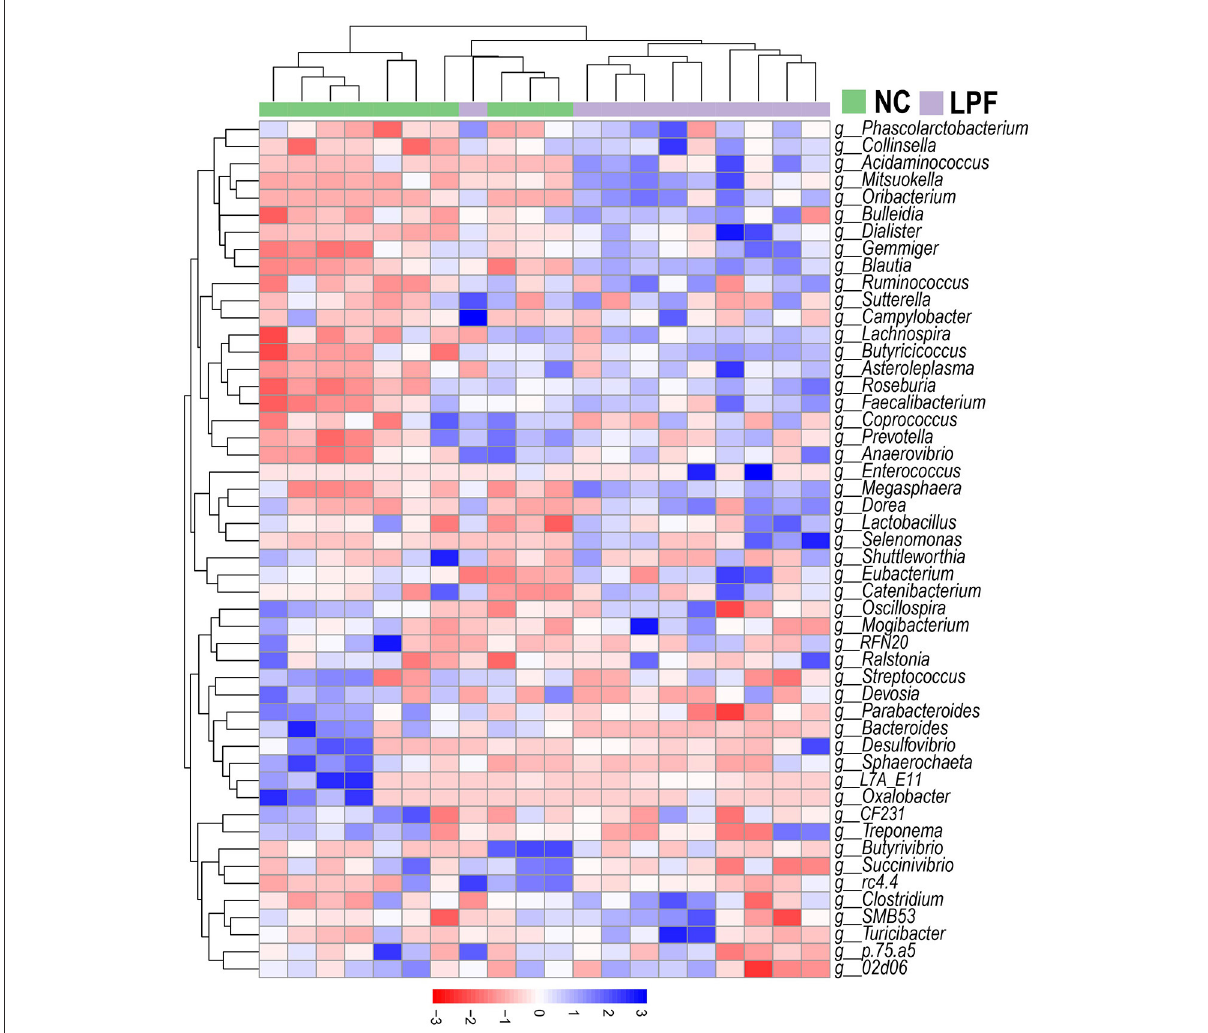
FIGURE4 Heatmap of the relative abundance of top 50 genera. Clusters based on Euclidean distance using complete linkage clustering. NC diet: basal diet, LPF diet: NC + 10% Lactobacillus plantarum and Pediococcus acidilactici co-fermented feed.